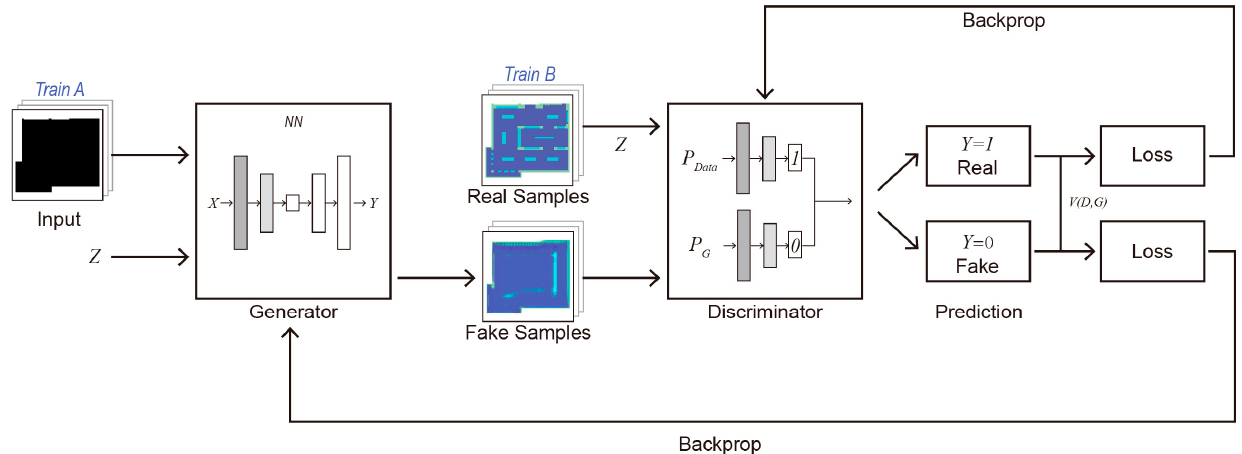
Figure 3. CGAN framework and principle.